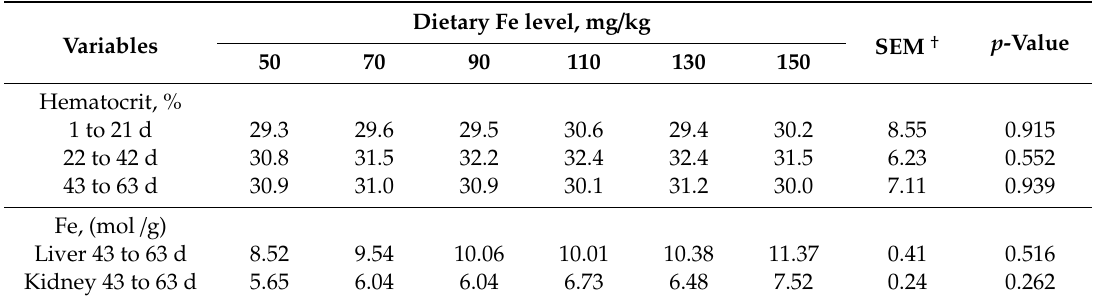
Table 4. E ff ects of dietary Fe on the hematocrit of Chinese yellow broilers during three 21-d experimental periods and Fe content of liver and kidney at 63 d. Variables